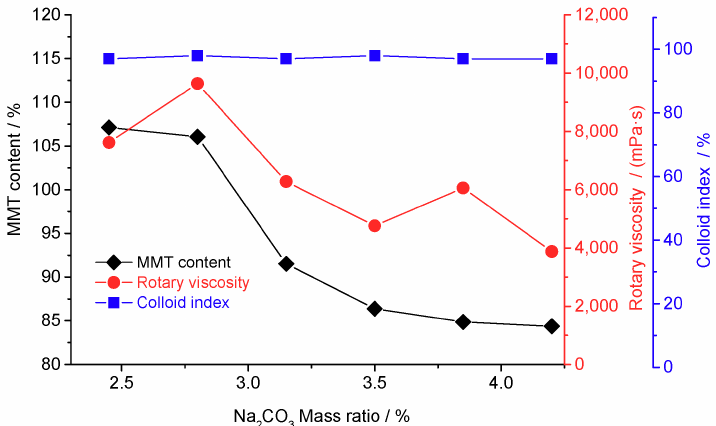
Figure 1. Properties of the montmorillonite (MMT) as a function of sodium carbonate addition (reaction conditions: 2 h, 25 °C, and stirring speed = 300 rev/min).